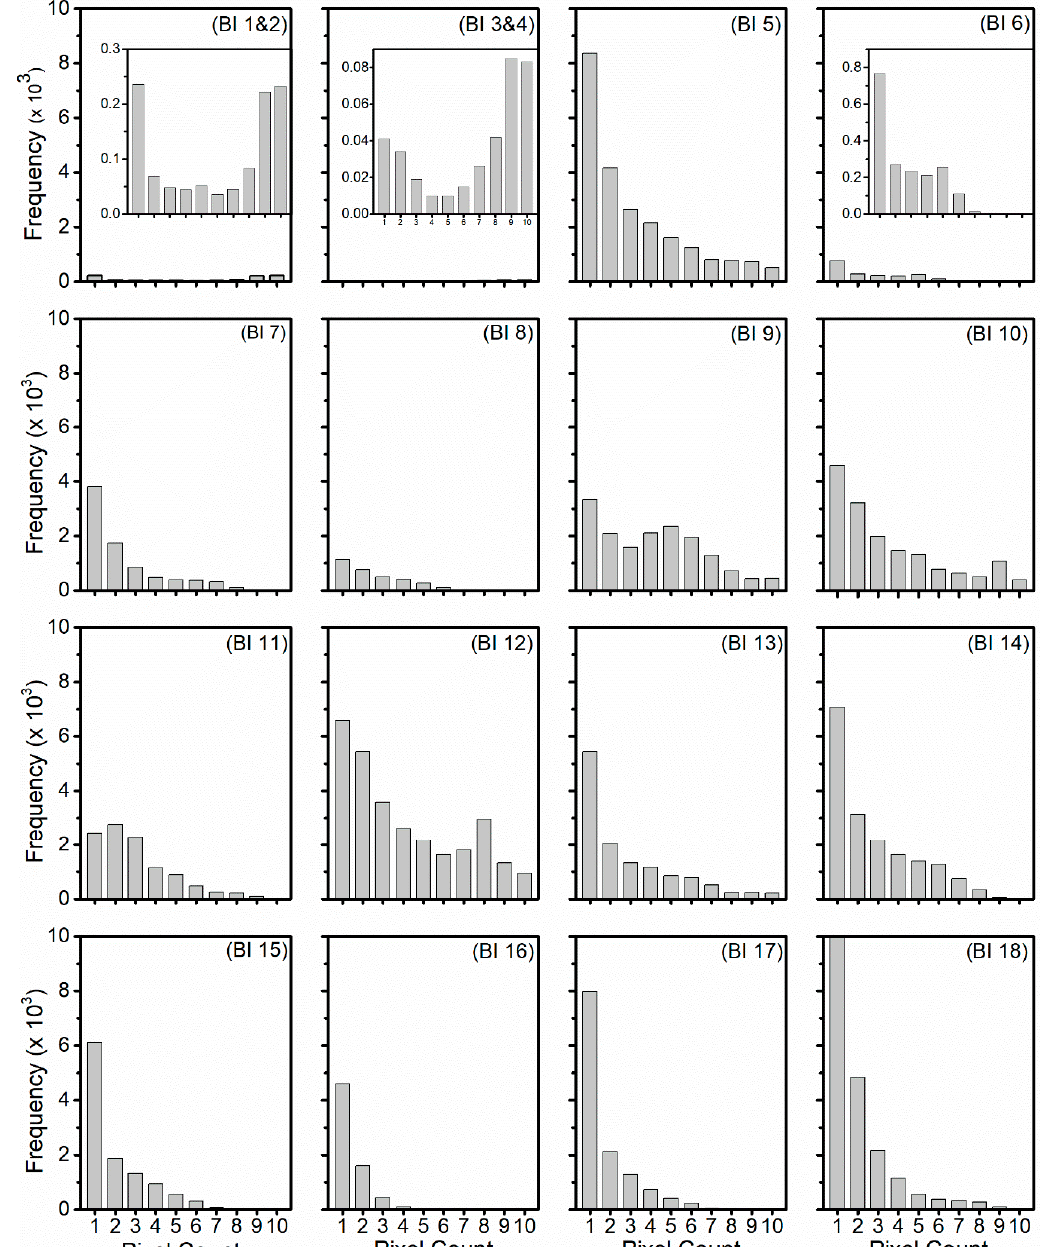
Figure 4. Frequency pixel count of Barrier Island. The inset views for BI 1&2, BI 3&4, and BI 6 show the frequency of the data between 0 and 1 × 10 3